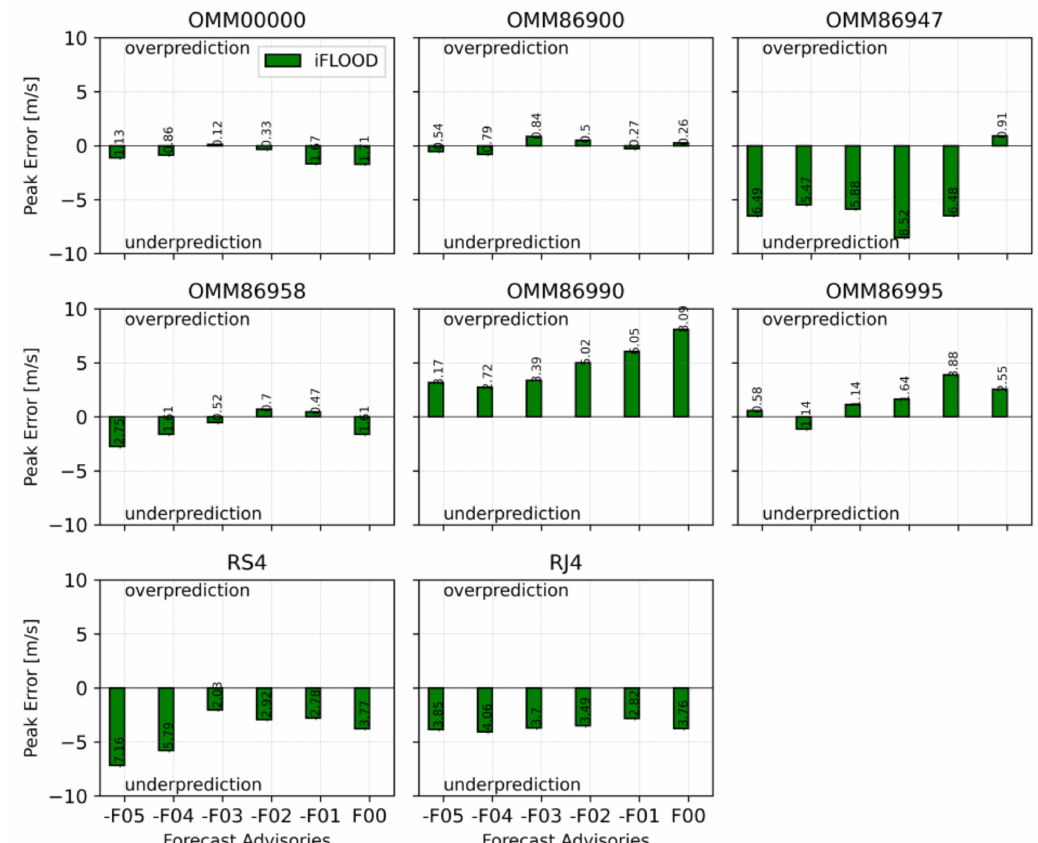
Figure 7. Bar plots of peak errors for forecasted maximum wind speeds (10 m height) at 6 meteorological stations and 2 wave recording stations during the bomb cyclone of 2020. F00 represents the forecast advisory on 1 July at 18:00 UTC, while the bars before F00 represent the forecasts issued earlier at 12 h